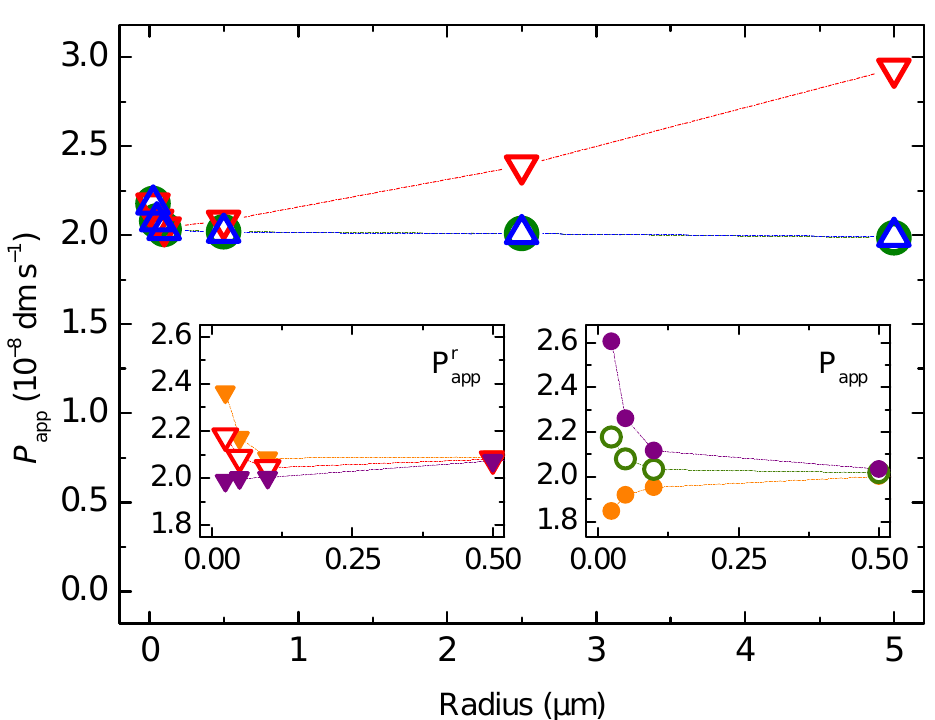
Figure 3. Apparent permeability coefficient calculated from the general equation ( P app ), and from (cid:35) the simplified equation ( P r app (cid:53) and P rV app ∆ ), as a function of the vesicle’s outer radius, with the total area of the barrier calculated from the interleaflet radius of the vesicles ( r io ), Equation (12). The insets shows the dependence for vesicles smaller than 500 nm and considering the outer ( • and (cid:72) ), the inner ( • and (cid:72) ), or the interleaflet ( and (cid:53) ) vesicles’ radius in the calculation of the total surface of the (cid:35) barrier; for P r app (left) and P app (right). The dotted lines are guides for the